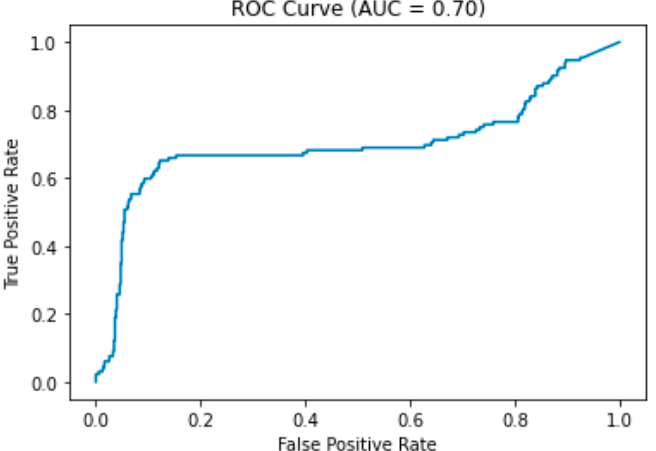
Figure 6. ROC curve of the prediction model with an area under the curve (AUC) of 0.7.